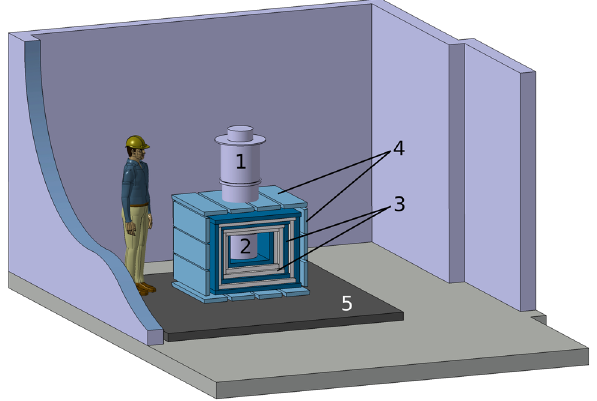
Fig. 7 Sketch of the NUCLEUS experiment at the VNS. The set-up consists of a cryostat (1), where the target detectors are installed in its lower part, the experimental volume (2). The latter is surrounded by a passive shielding (3) consisting of alternating layers of borated PE and lead. The top part will be completed by a cold shield inside the cryostat. The outermost layer is the active muon veto (4) made from plastic scintillatorpanels.Thefullset-upwithafootprintofapproximately1m 2 is placed on a weight support platform (5). Further support structures, e.g. for the cryostat, are omitted for clarity. The schematics shows an